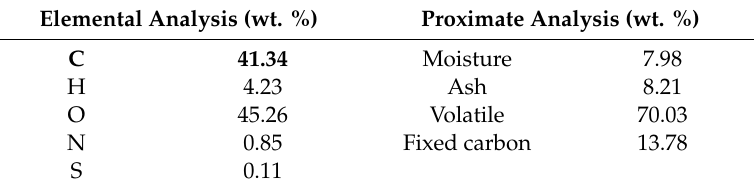
Table 1. The ultimate and proximate analysis of soybean